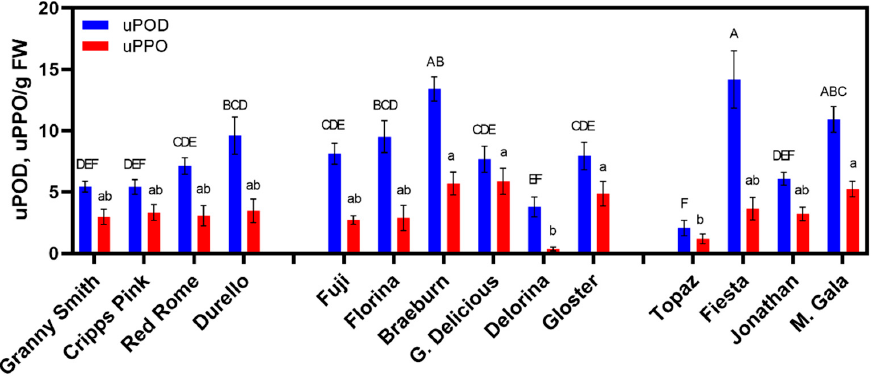
Figure 3. Average enzyme activity for POD (uPOD) and PPO (uPPO). Means displayed are averages of all three times. Means ± standard error displayed. Different letters above bars indicate differences according to Student-Newman-Keuls (SNK) post-hoc mean comparison at a p < 0.05. No significant interactions were detected by cultivar x time for enzymatic activities when assessed by ANOVA at p < 0.05.